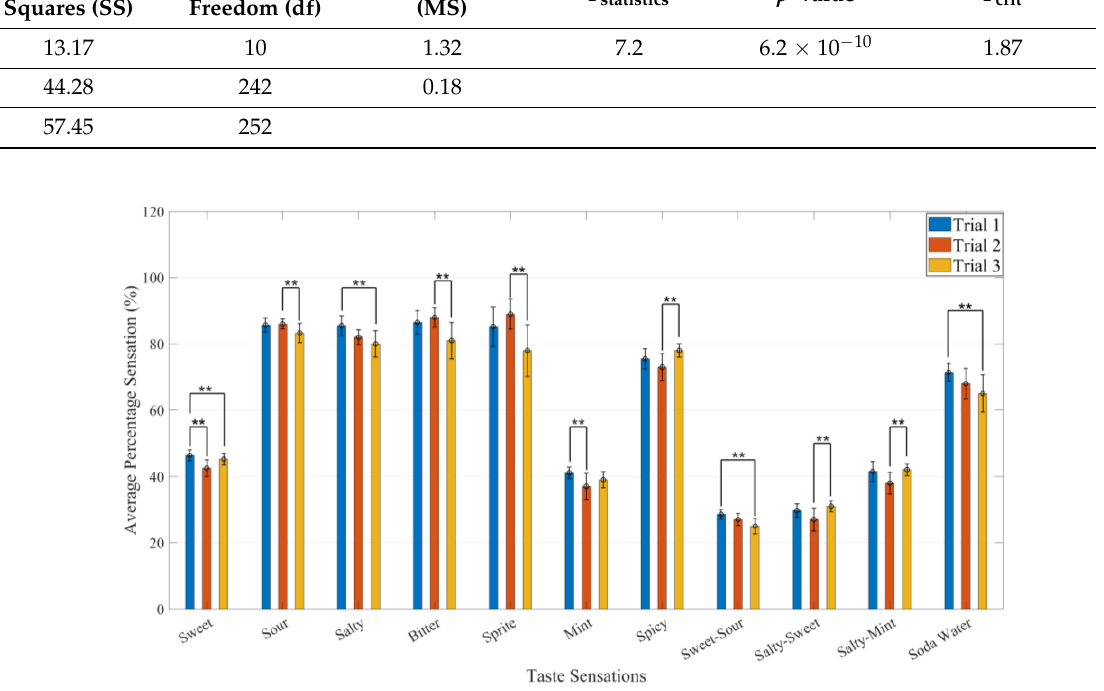
Figure 7. The average percentage of taste sensations of 23 participants with repeated experiments. Error bar depicts 90–98% CI. All data are expressed as mean ± SD ** p ≤ 0.05.